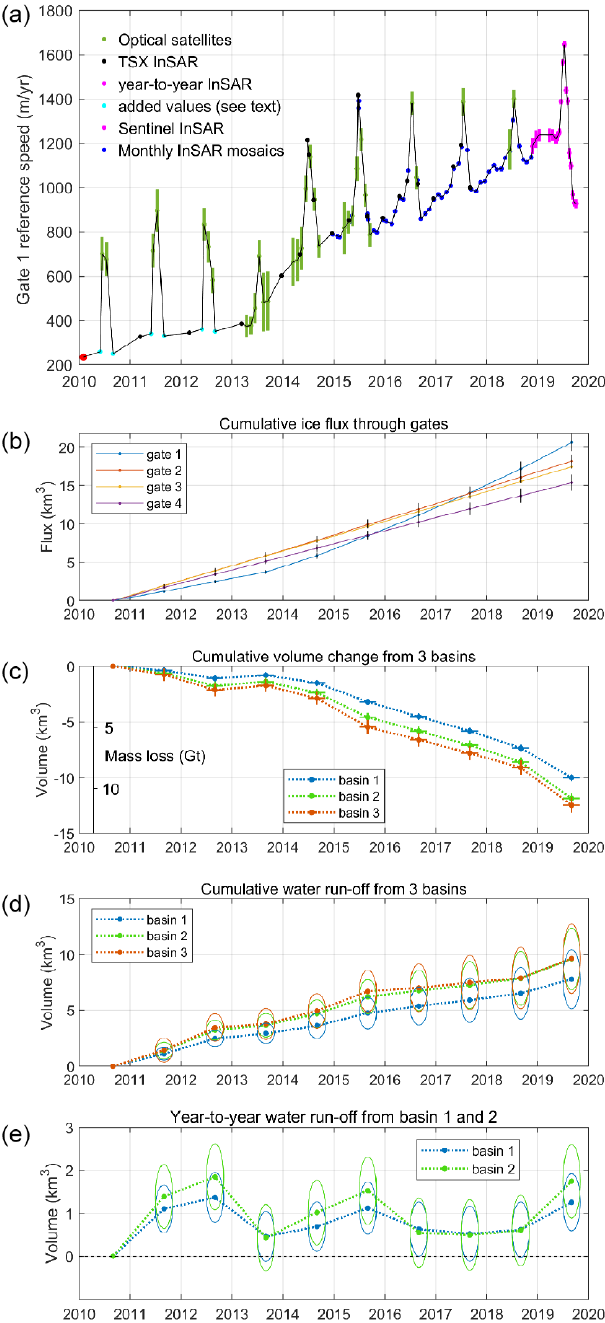
Figure 2. (a) Temporal variation in surface speed at the reference point on gate 1. (b) Cumulative year-to-year ice flux through the four gates. (c) Cumulative volume of ice and mass lost by the three basins over the 9 years. (d) Cumulative water run-off from the three basins. The ellipses around each point are an indication of (verti- cally) the potential uncertainty in the result and (horizontally) the time period of the CryoSat data used in estimating the volume change. (e) Year-to-year variation in water run-off from basins 1 and